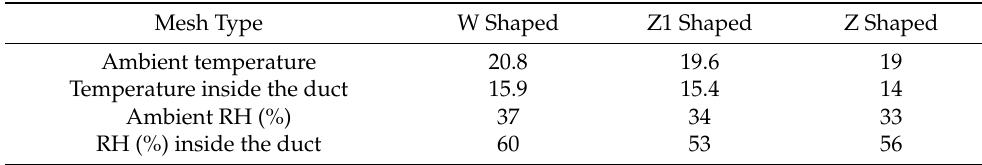
Table 2. Measurement sequence (1 hr average) for the three types of the metal cooling pad cross- sectional